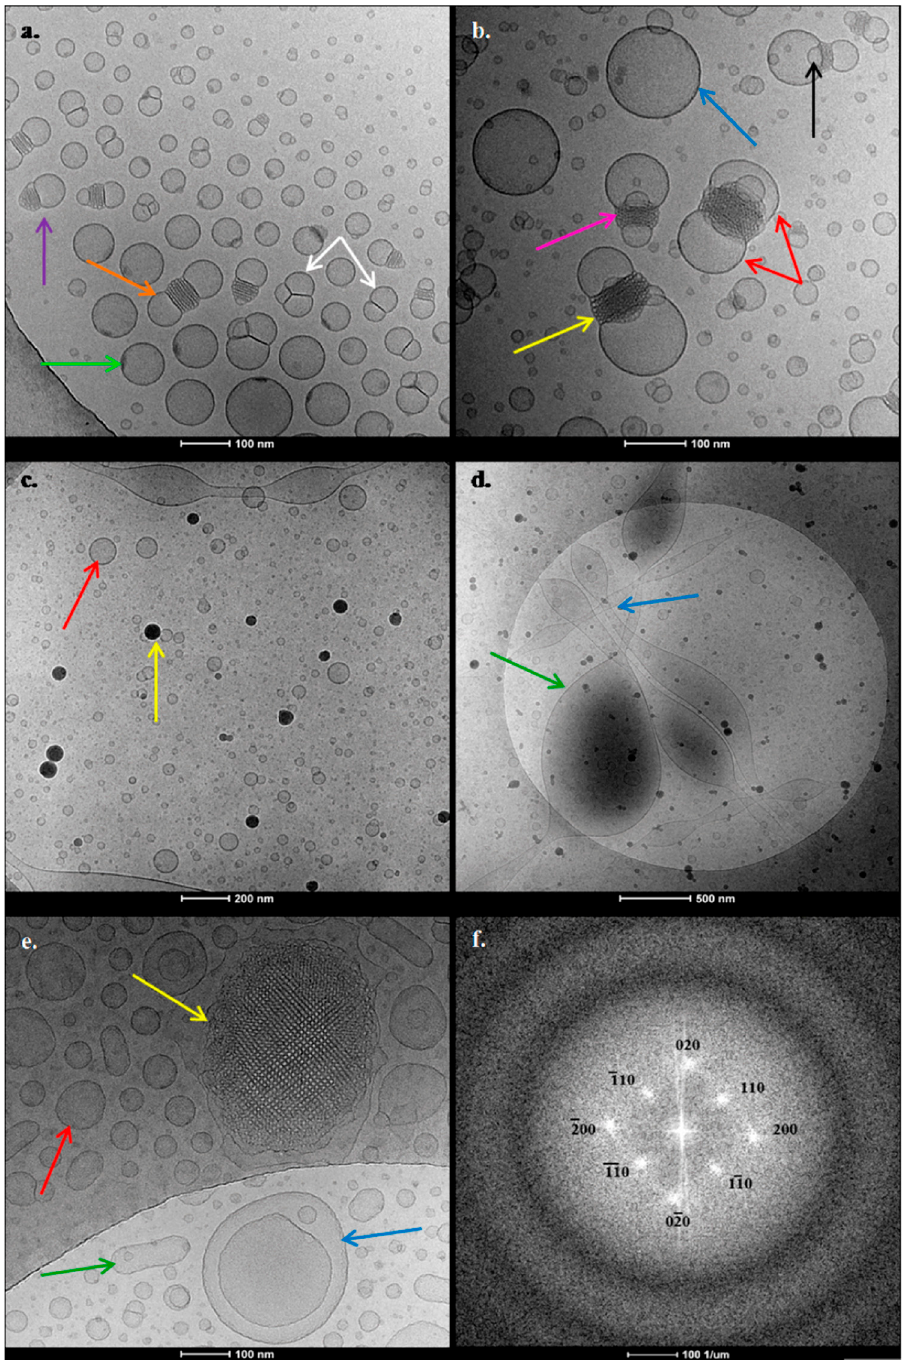
Figure 6. Cryo-TEM images of GMO:PDMAEMA-b-PLMA 9:1 ( a,b ), GMO:PDMAEMA-b-PLMA 9:3 ( c,d ), GMO:PDMAEMA-b-PLMA:P407 8:1:1 ( e ) and ( f ) FFT pattern from GMO:PDMAEMA-b-PLMA:P407 8:1:1 particle (yellow arrow) likely with the space group Im3m . Table 5. Size and morphological characteristics of the existing vesicles of the GMO prepared systems, acquired by Cryo-TEM.